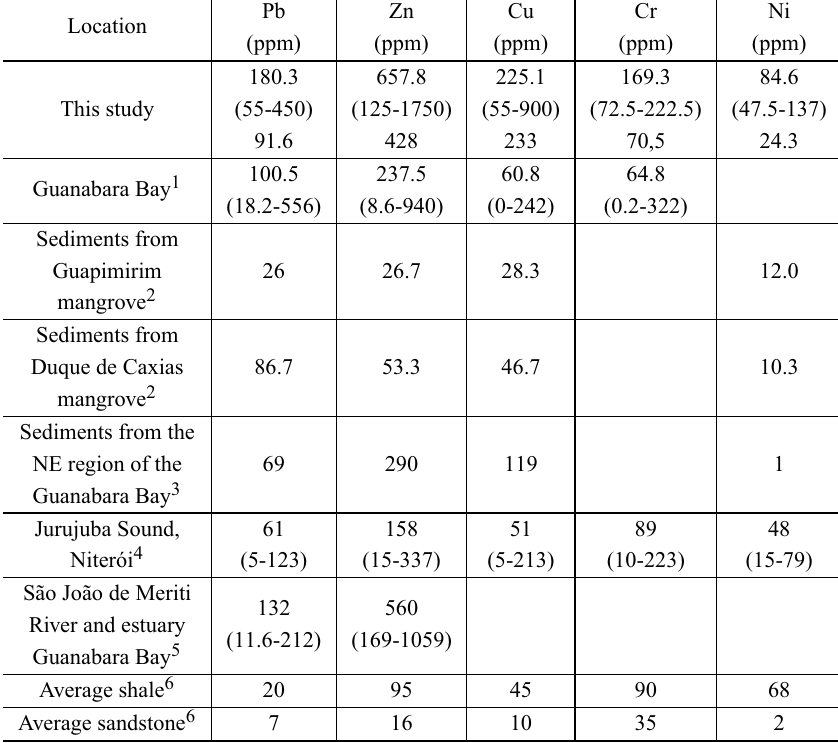
Heavy metal concentration (ppm) in the study area (average) (minimum value ± maximum value) (average SD), compared with values from the